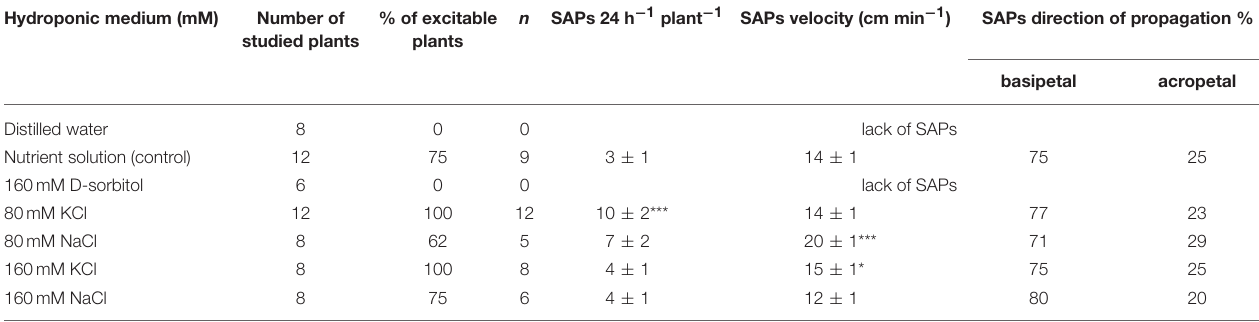
TABLE 1 | Parameters of spontaneous excitation in Helianthus annuus seedlings under osmotic and salt stresses. Hydroponic medium (mM)